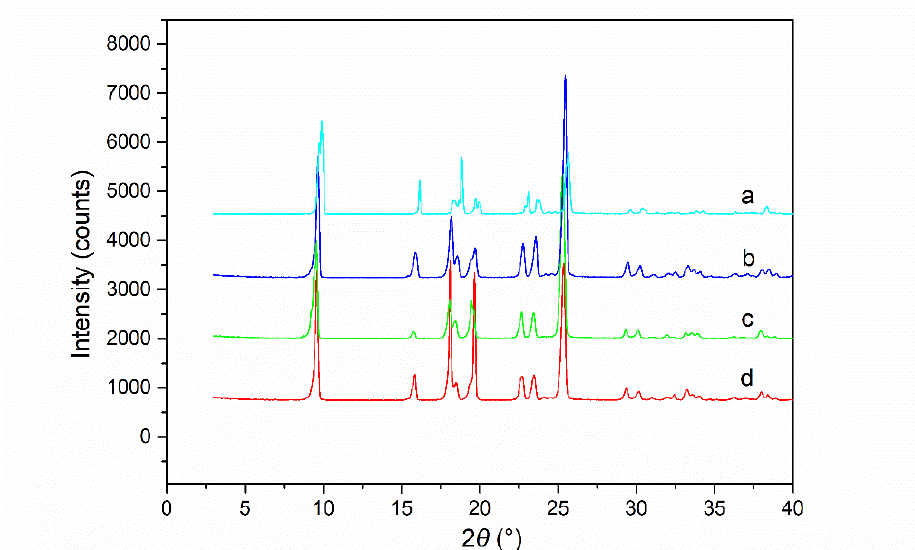
Figure 2. Powder X-ray diffraction ( PXRD) patterns of the catechol crystals: ( a ) the raw material and the products crystallized from ( b ) ethyl acetate, ( c ) methyl acetate, and ( d ) isopropanol.